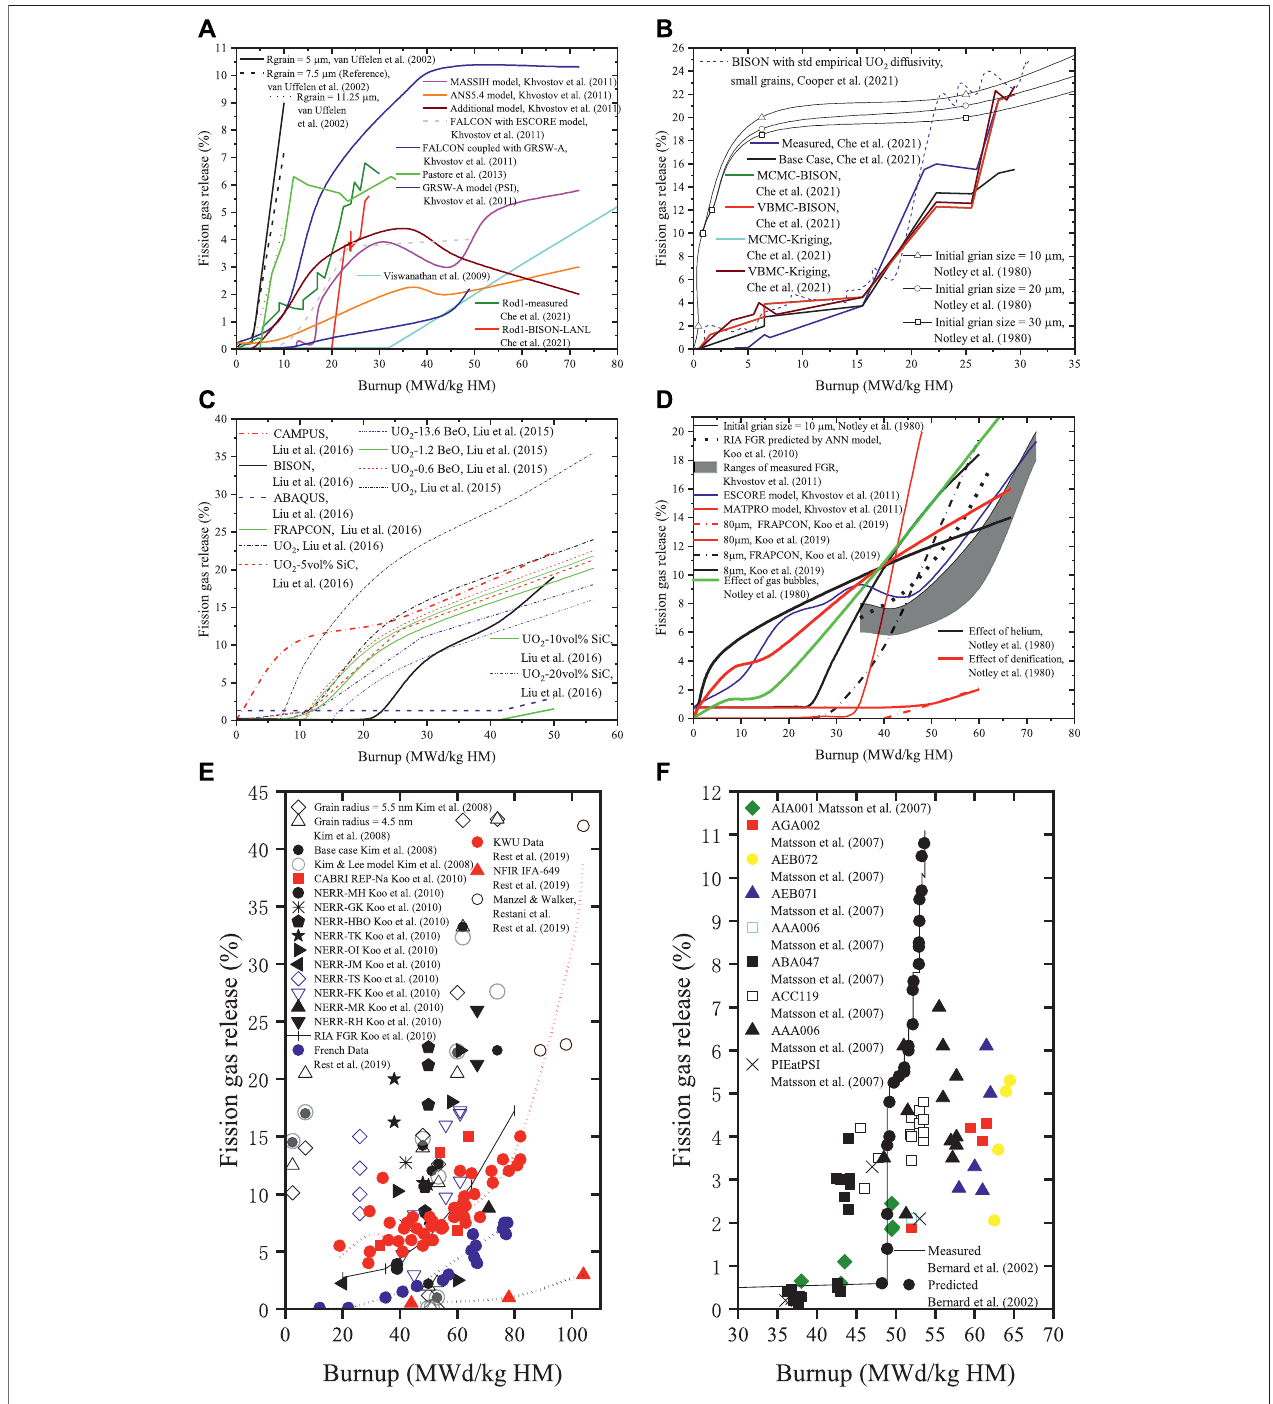
FIGURE1|(A – F) Fissiongasreleasevs.burnupintheUO 2 fuel(Notleyetal.,1980;Kogai,1997;Bernardetal.,2002;vanUffelenetal.,2002;Matssonetal.,2007; Kimetal.,2008;Viswanathanetal.,2009;Kooetal.,2010;Kooetal.,2010,2019;Khvostovetal.,2011;Pastoreetal.,2013;Liuetal.,2015;Liuetal.,2016;Restetal., 2019; Che et al., 2021; Cooper et al., 2021). (G – J) Fission gas release vs. time in the UO 2 fuel (Evans, 1996; Kogai, 1997; Zacharie et al., 1998; Khvostov et al., 2011; Pastore et al., 2013; Andersson et al., 2014; Wu et al., 2018; Verdolin et al., 2020). (K,L) The predicted fi ssion gas releases to the measured ones in the UO 2 fuel (Notley et al., 1980; Kogai, 1997; Bernard et al., 2002; Barani et al., 2020).